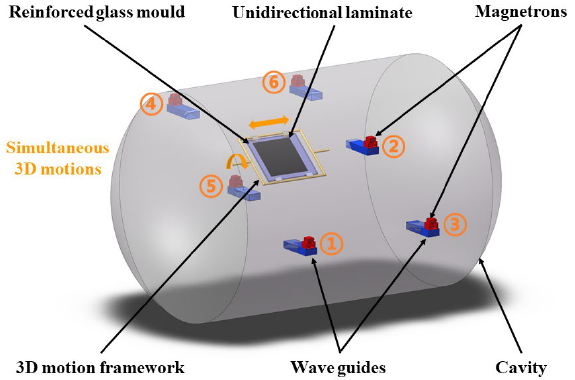
Figure 1. Schematic diagram of the recently developed microwave oven and composite plate used in the experiment.